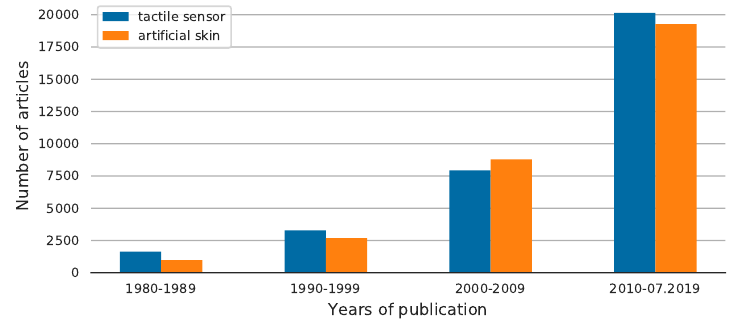
Figure 7. Timeline of interest in artificial tactile